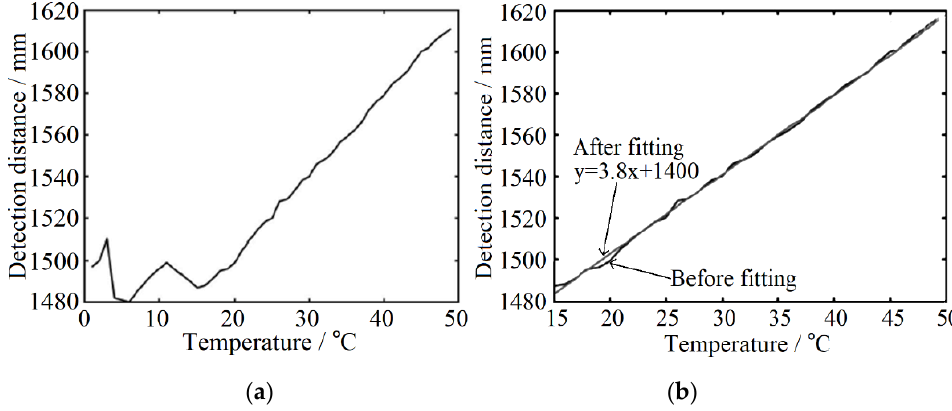
Figure 8. Variation curve of ranging results with temperature ( a ) and its fitting results ( b ).